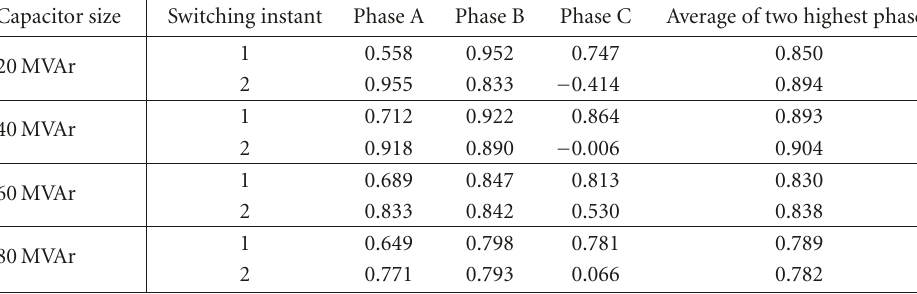
Table 2: Results of back-to-back capacitor switching with 40 MVAr